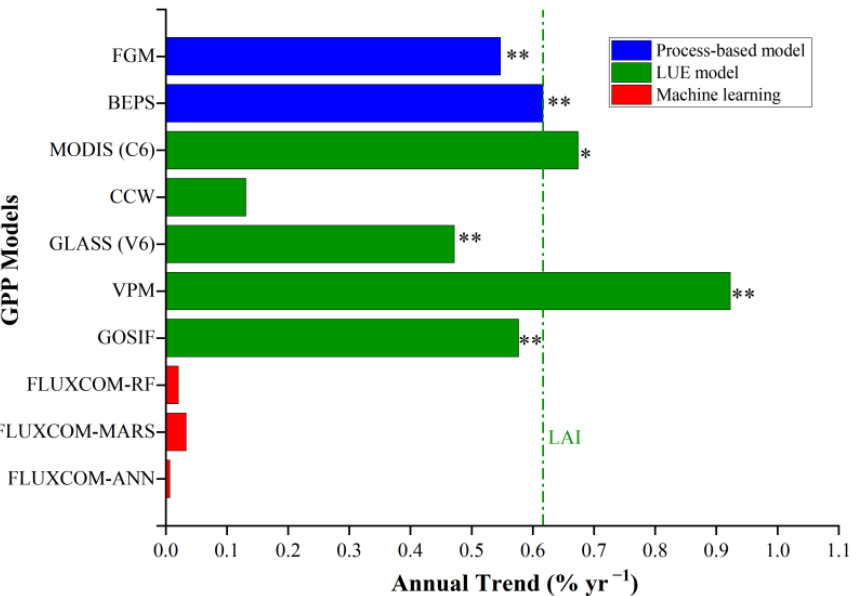
Figure 11. Interannual trends in the GPP and LAI scaled by multiple-year means. The vertical dashed line indicates the rate of change in the LAI itself from 2001 to 2016 based on the GLASS LAI product. ** and * indicate increasing trends in the total annual GPP from 2001 to 2016 at p -value < 0.05 and p -value < 0.01, respectively. GPP = gross primary production; LUE = light use efficiency; LAI = leaf area index.